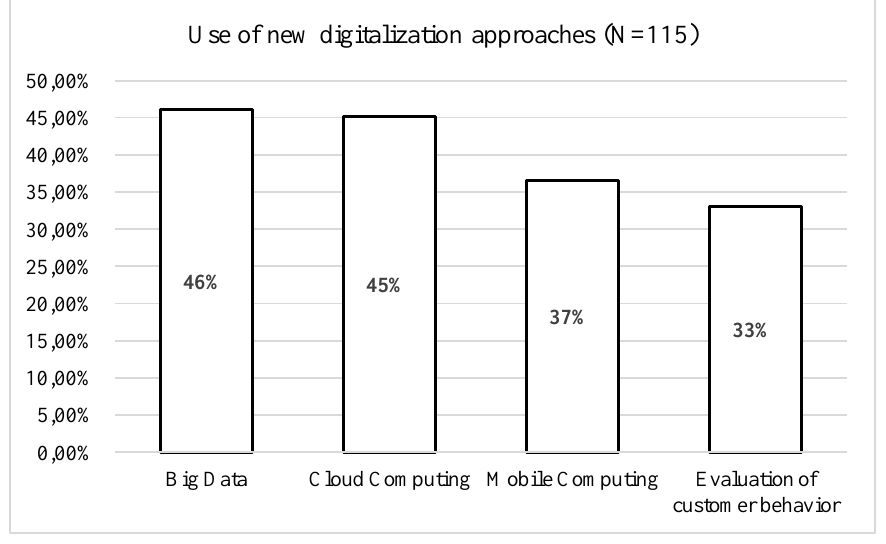
Figure 3. Use of new digitalization approaches based on survey